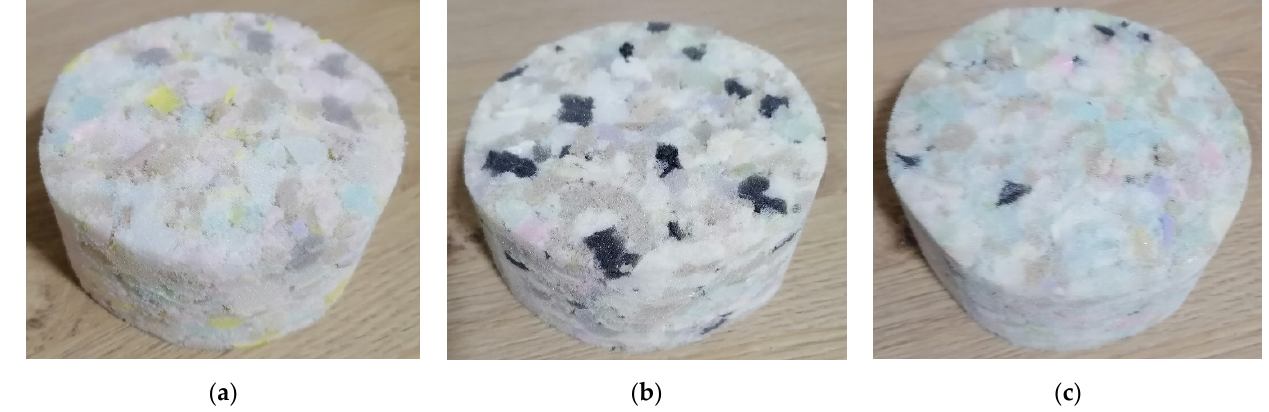
Figure 1. RPUF samples with different densities for experimental testing: ( a ) ρ = 40 kg/m 3 ; ( b ) ρ = 55 kg/m 3 ; ( c ) ρ = 80 kg/m 3 .